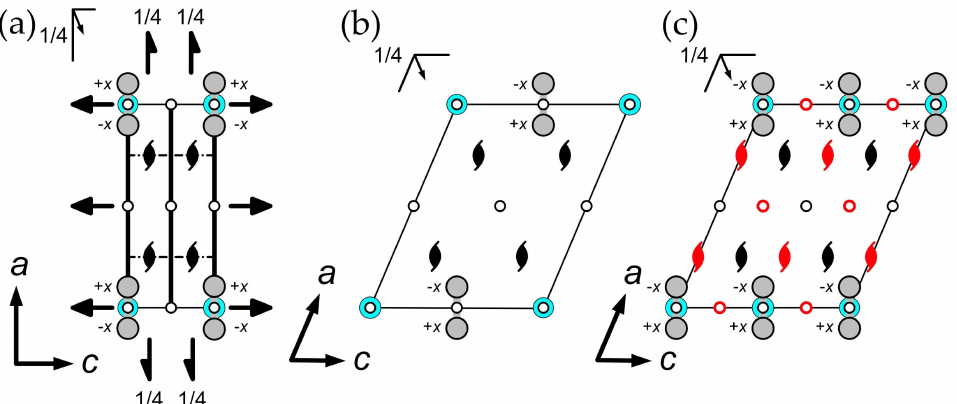
Figure 5. Projections of Cu and C atoms onto the (010) plane along the ± 1/4 b direction in ( a ) the OP model, ( b ) the perfectly ordered monoclinic model and ( c ) the disordered monoclinic model. For the sake of clarity, symmetry elements are superimposed over unit cell boundaries (thin black line) and atoms. Symmetry elements denoted in red in ( c ) are the result of the disorder occurrence (see text for details). Atoms in ( a ) and ( c ) are half-occupied. Legend: Cu = cyan; C = gray; O atoms are excluded for